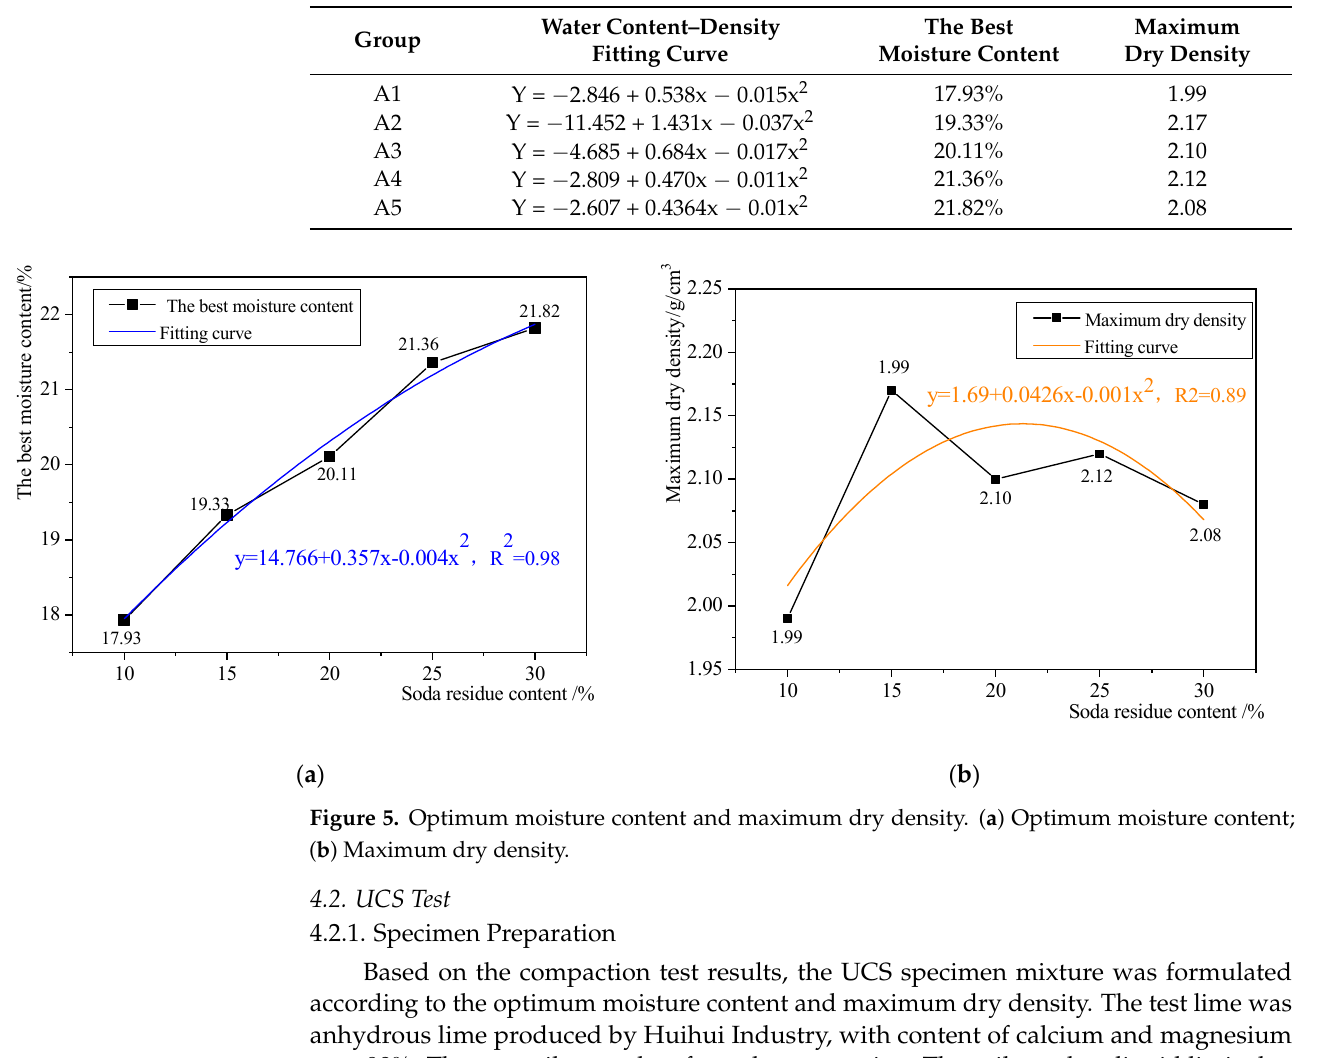
Table 4. Fitting results of moisture content–dry density.